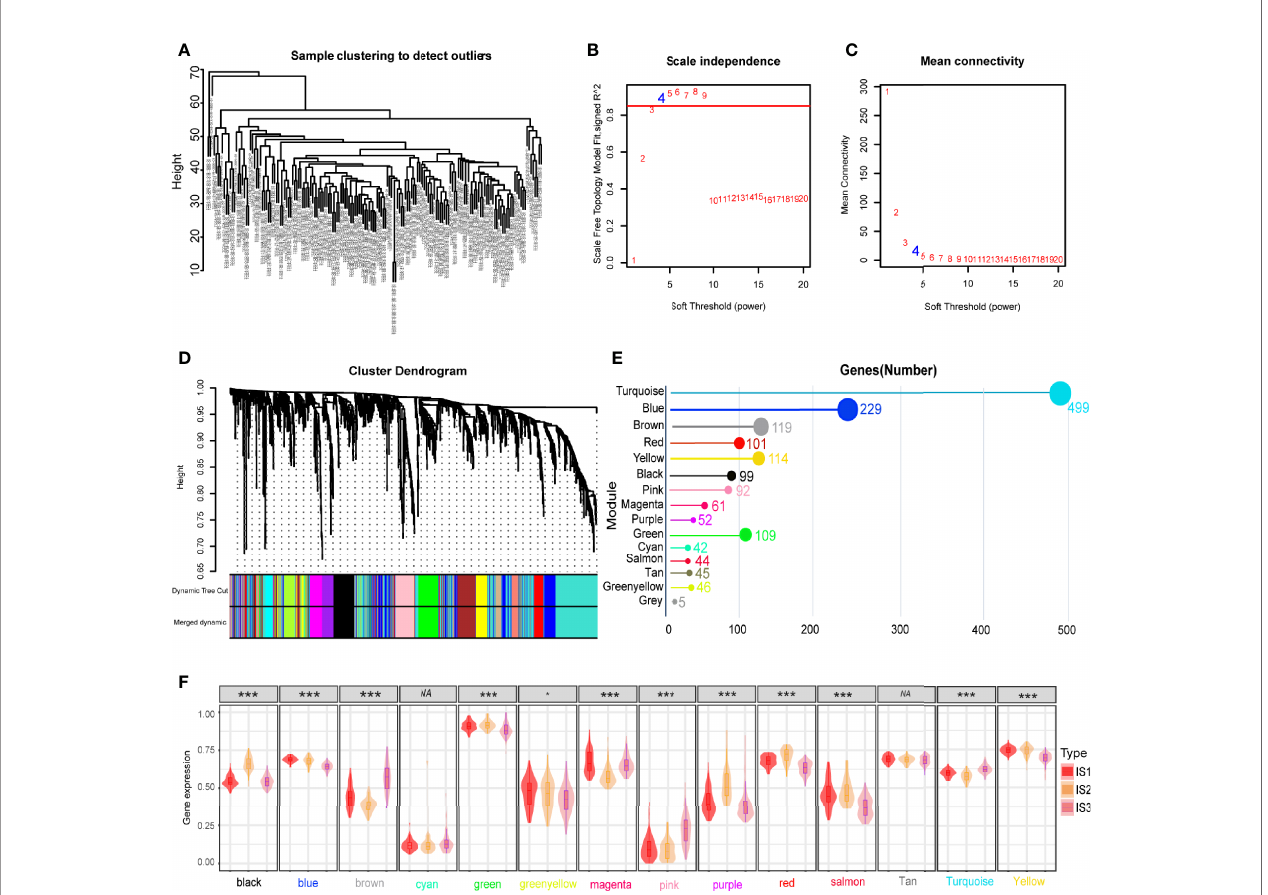
FIGURE 8 | Identi fi cation of immune gene co-expression modules of GBM. (A) Sample clustering. (B) Scale-free fi t index for various soft-thresholding powers ( b ). (C) Mean connectivity for various soft-thresholding powers (D) Dendrogram of all differentially expressed genes clustered based on a dissimilarity measure (1-TOM). (E) Gene numbers in each module. (F) Differential distribution of feature vectors of each module in GBM subtypes. * p < 0.05, ** p < 0.01, *** p <